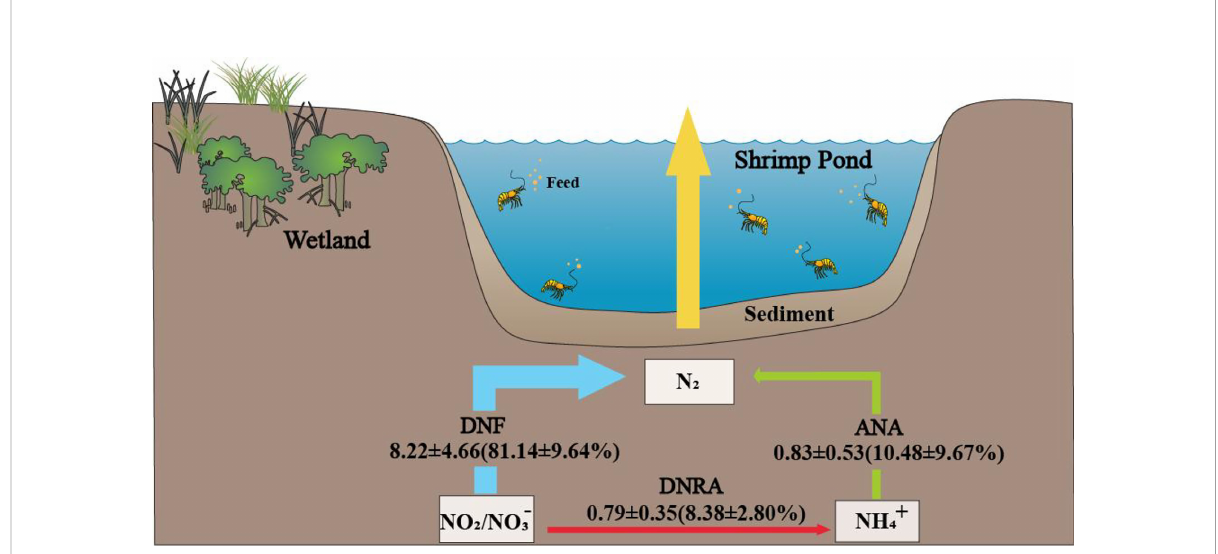
FIGURE 6 The conceptual map on NO 3 − reduction processes in the shrimp pond sediment. The unit of DNF, ANA, and DNRA rates were nmol N g -1 h -1